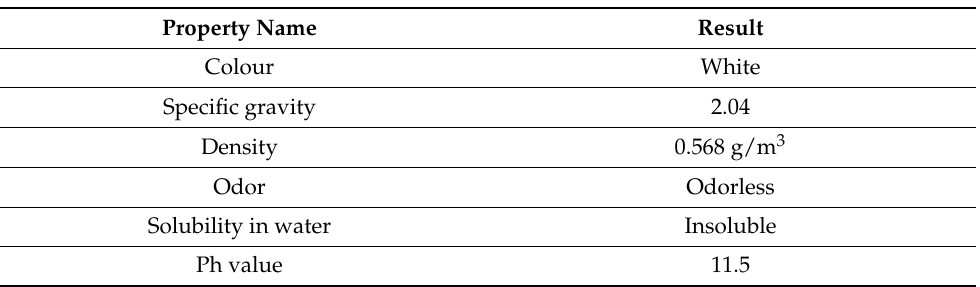
Table 4. Zeolite physical properties.